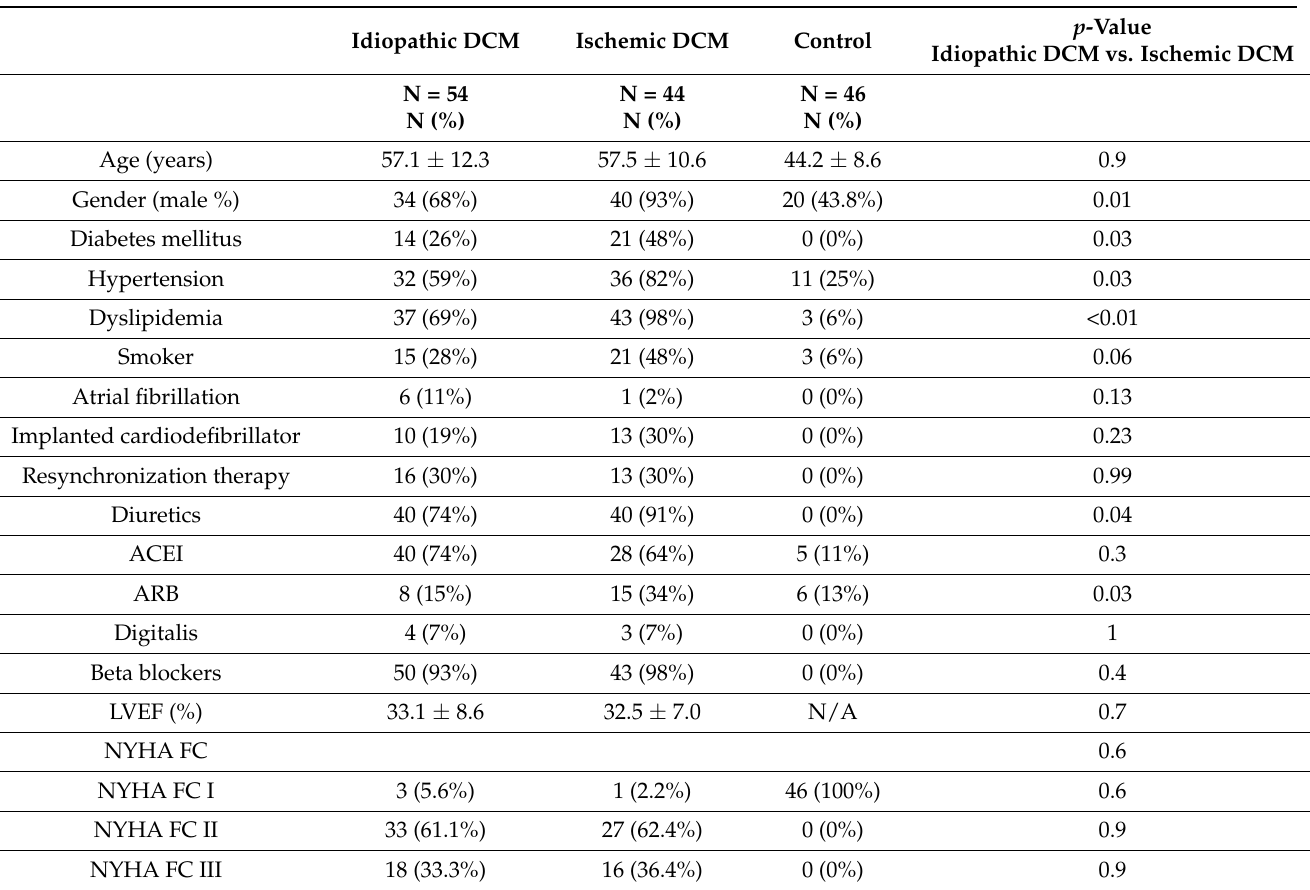
Table 1. Patients’ and controls’ baseline